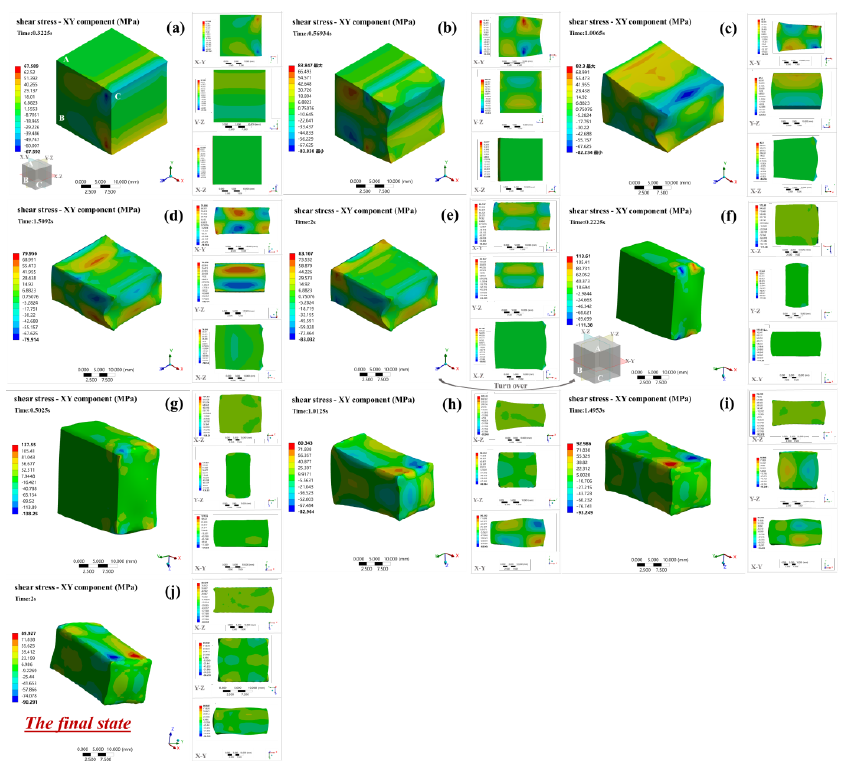
Figure 10. The shear − stress distribution of MD − rolled alloys. The graphs are cut from different time points of deformation. ( f − j ) are redefined according to the time after the specimen is turned over. ( a ) 0.3225 s; ( b ) 0.56934 s; ( c ) 1.0065 s; ( d ) 1.5092 s; ( e ) 2 s; ( f ) 0.2225 s; ( g ) 0.5025 s; ( h ) 1.0125 s; ( i ) 1.4953 s; ( j ) 2 s.